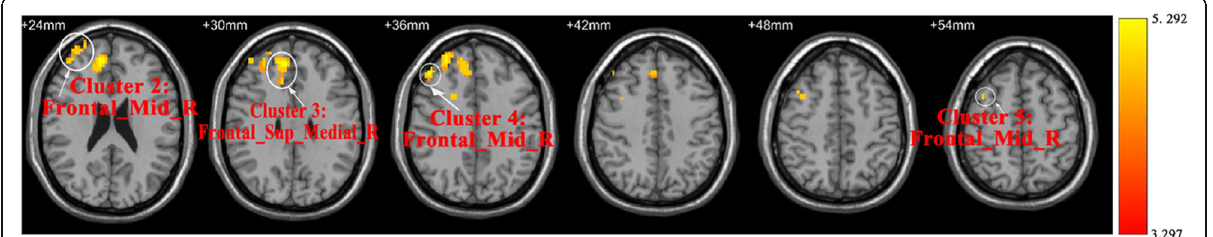
Fig. 2 The regional homogeneity (ReHo) differences in the slow-5 band of 0.01 – 0.027 Hz. Warm colors indicate regions showing higher ReHo in TTH patients versus the HCs [ P FWE < 0.01, Threshold-Free Cluster Enhancement (TFCE)